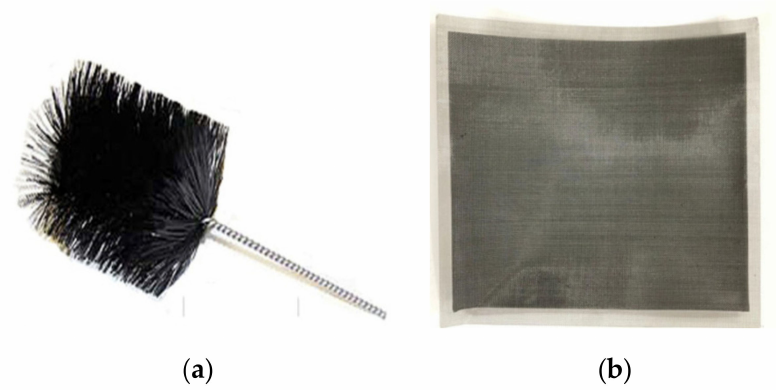
Figure 2. Selected electrodes: ( a ) Anodic electrode, ( b ) and cathodic